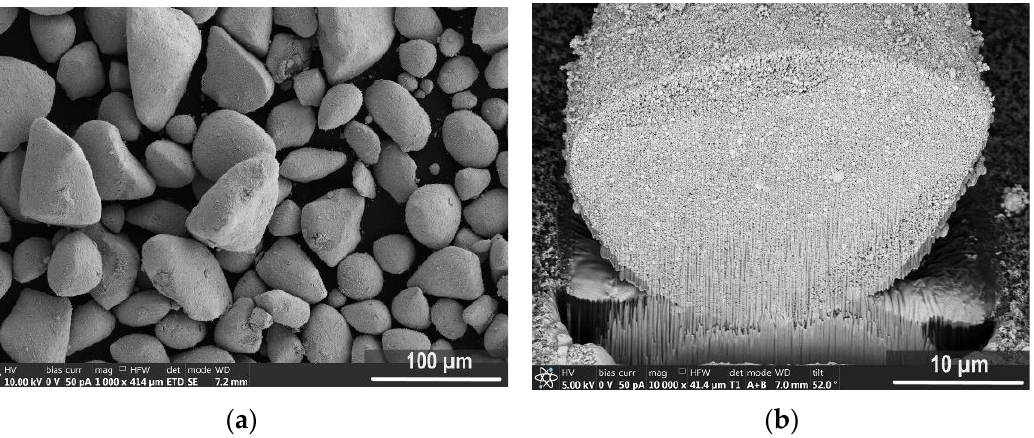
Figure 3. SEM images of microgranules on the base of W-5Ni-2Fe nanopowder ( a ), cross-section of microgranules after mechanical grinding ( b ).